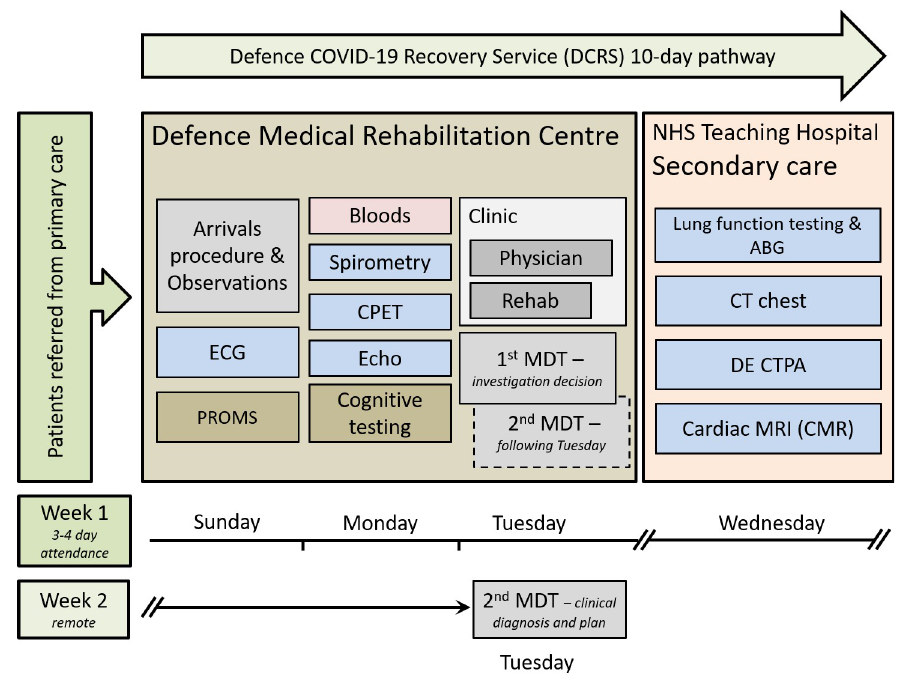
Fig 1. Flow chart of the defence COVID-19 recovery service pathway. ECG—electrocardiogram; PROMS–patient reported outcome measures, CPET–cardiopulmonary exercise test; MDT–multidisciplinary team meeting; ABG– arterial blood gas; CT High resolution computed tomography; DE CTPA–dual energy CT pulmonary angiogram; MRI–magnetic resonance imaging.